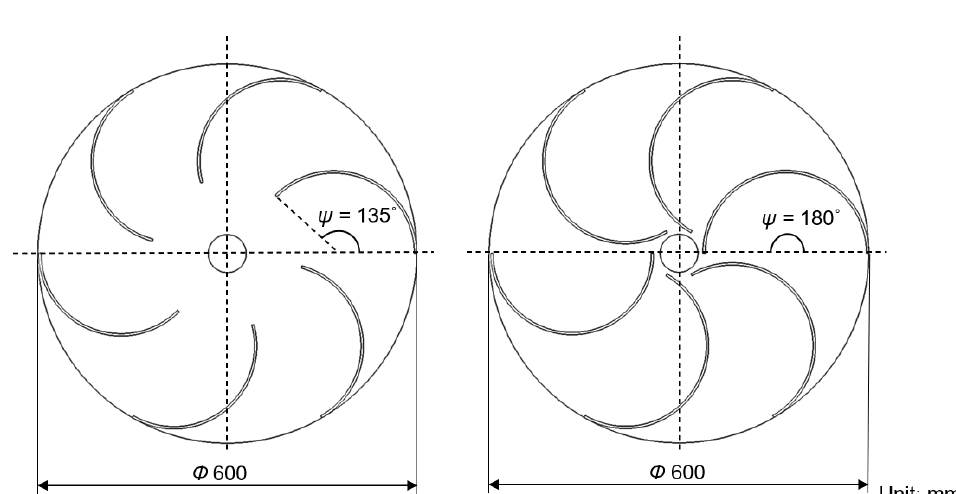
Figure 2. The geometry of the turbine blades with different arc angles ( ψ = 135° and 180°).